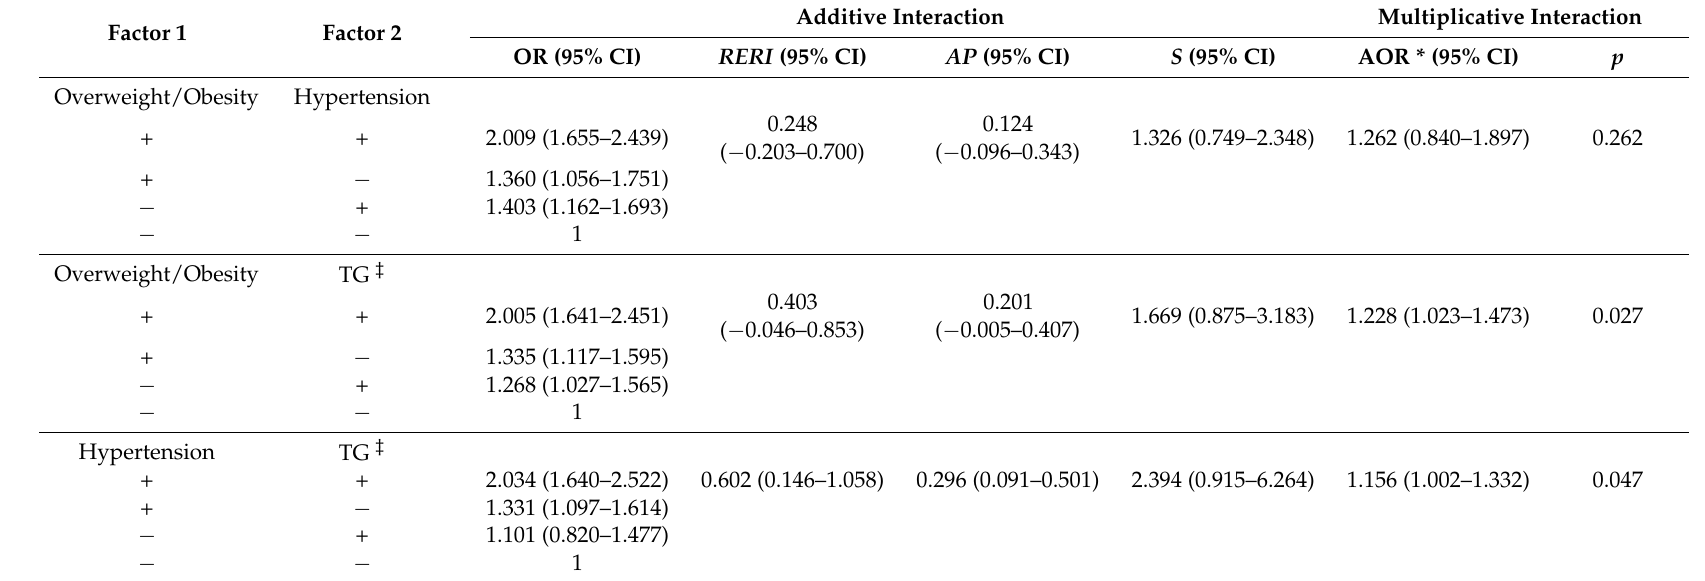
Table 5. Interaction of risk factors for